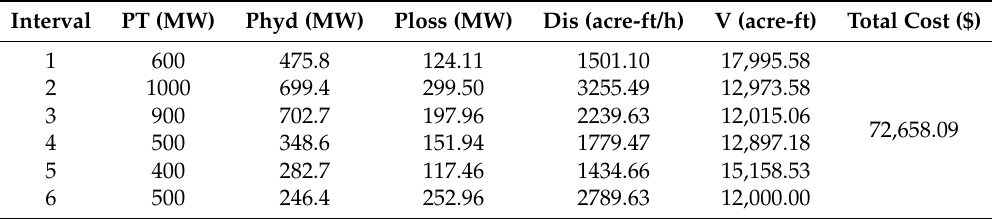
Table 14. Power flow and cost optimization with the improved APSO algorithm implementation on the non-cascaded non-pumped-storage STHTS problem while not considering transmission losses.